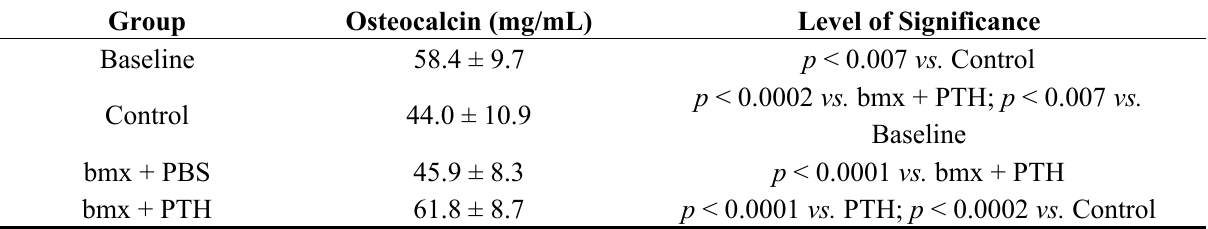
Table 3. Serum osteocalcin concentration. n = 8 for Control; n = 12 for all other